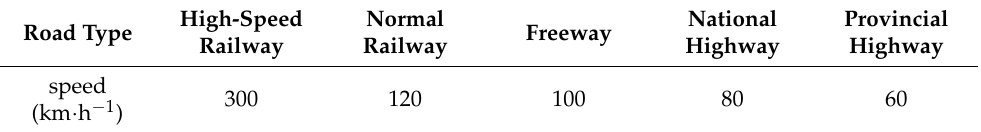
Table 1. Average running speed of different types of roads. Road